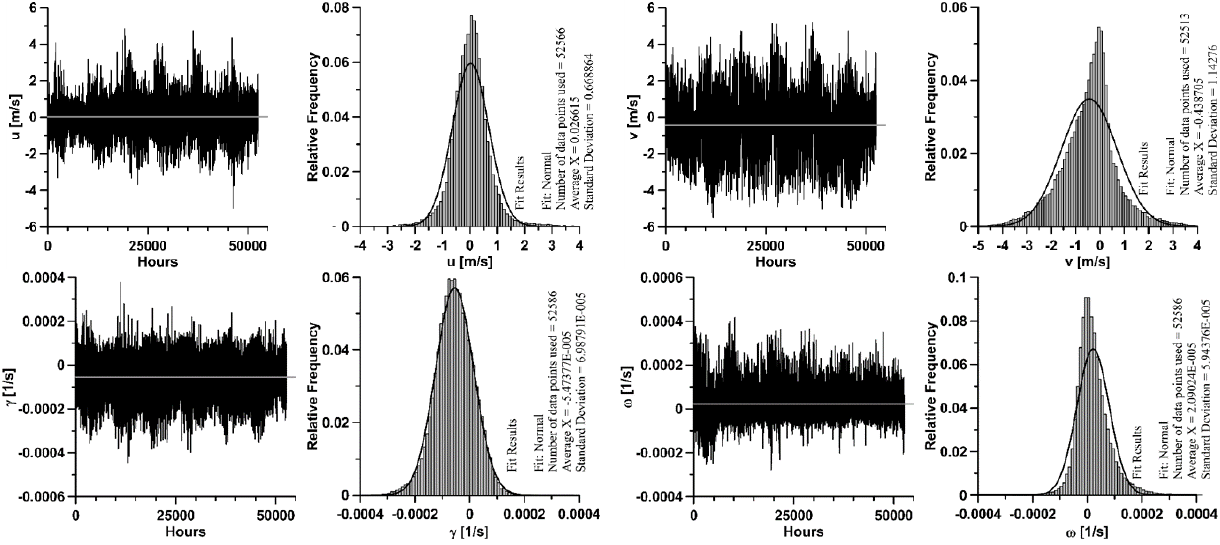
Figure 4. Temporal behavior ( left ) and frequency distribution ( right ) of the Mexico City wind state parameters during the period 2001-2006.Top row: velocity components (u, v). Bottom row: divergence (γ) and vorticity (ω). Fittings to normal distributions are shown for comparison purposes.